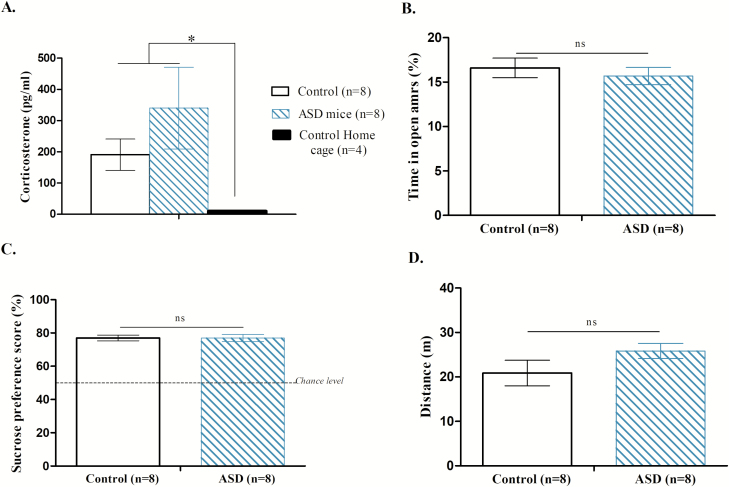
Control experiments. Effect of sleep debt (ASD) on stress, locomotion, sucrose preference, and anxiety. A. Level of corticosterone (pg/mL) for control mice (in the cylinder at rest, white bar, n = 8), ASD mice (n = 8) and control home cage mice (n = 4). * represents a significant difference between control home cage mice and ASD, control mice. B. Control (white bar, n = 8) and ASD (hatched bar, n = 8) mice did not differ from each other regarding the percentage of time spent in the open arms (mean ± SEM) during the Elevated Plus Maze (p > 0.5). C. Control (white bar, n = 8) and ASD (hatched bar n = 8) mice did not differ from each other regarding the sucrose preference score (mean ± SEM) after ASD (p > 0.5). D. Control (white bar, n = 8) and ASD mice (hatched bar, n = 8) did not differ from each other regarding the distance traveled in the locomotor activity paradigm (mean ± SEM [p > 0.5]).